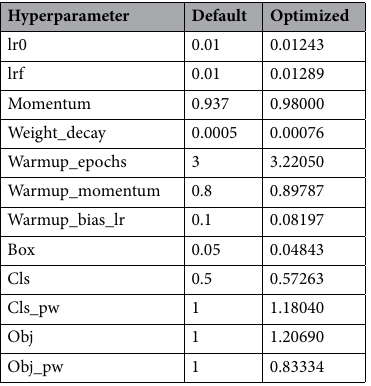
Table 3. The default and optimized hyperparameters in